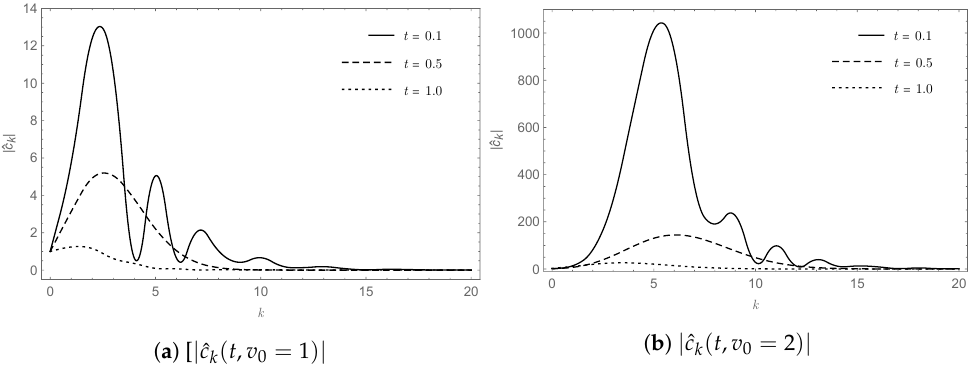
Figure 9. The sequences of | ˆ c k ( t , v 0 ) | ’s computed from (32) and (33) in Example